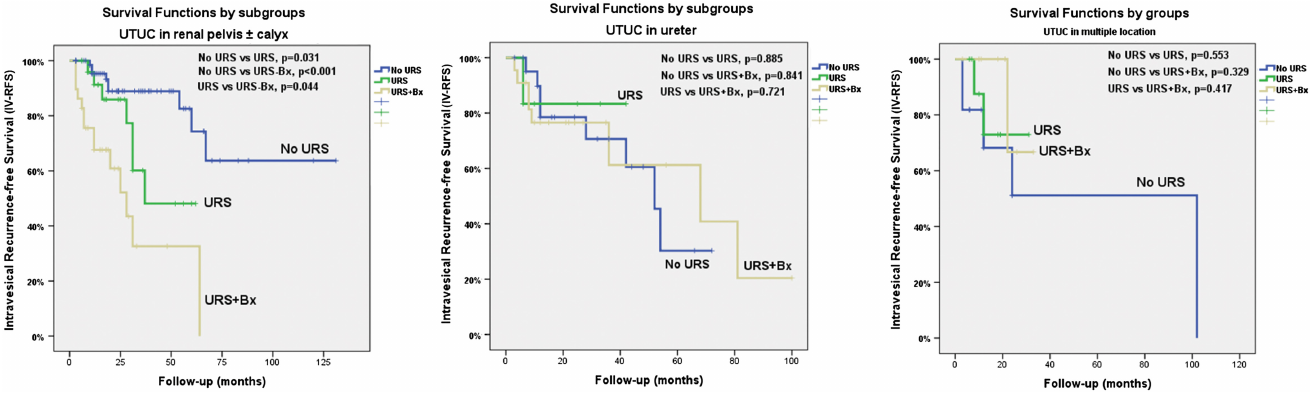
Figure 3. Kaplan–Meier curves for intravesical recurrence-free survival according to tumor location. URS: ureterorenoscopy, bx: biopsy, UTUC: upper tract urothelial